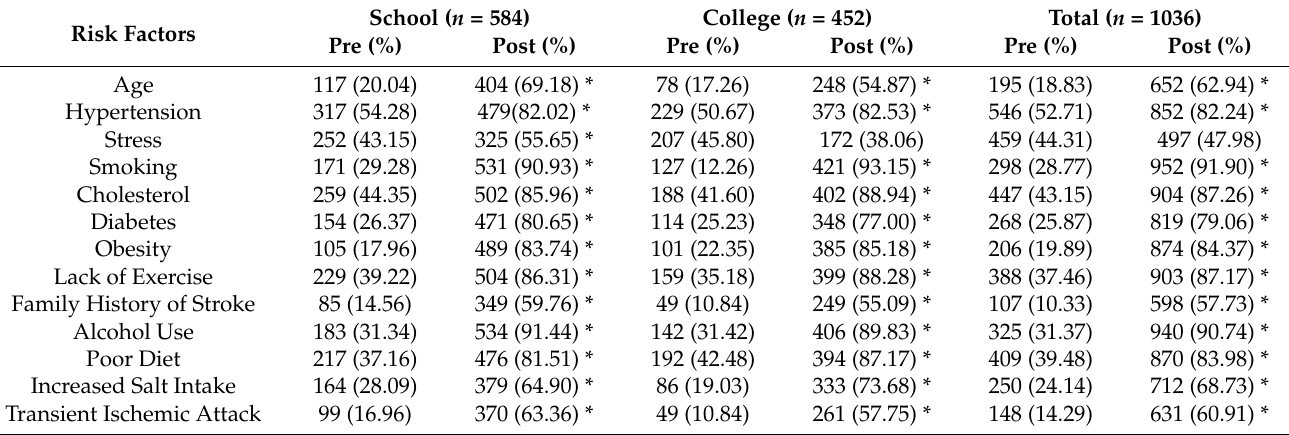
Table 3. Knowledge about risk factors of